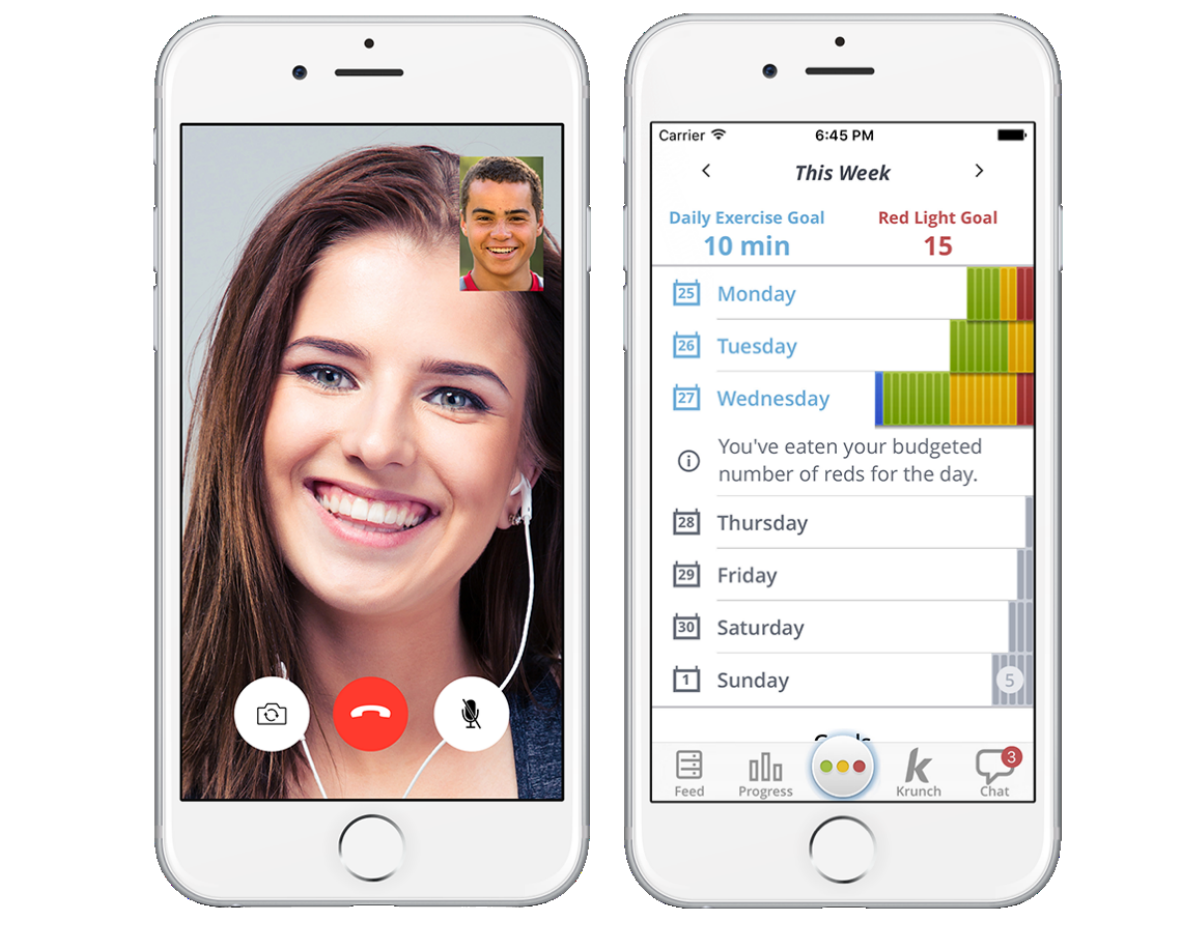
Figure 1. Mobile app